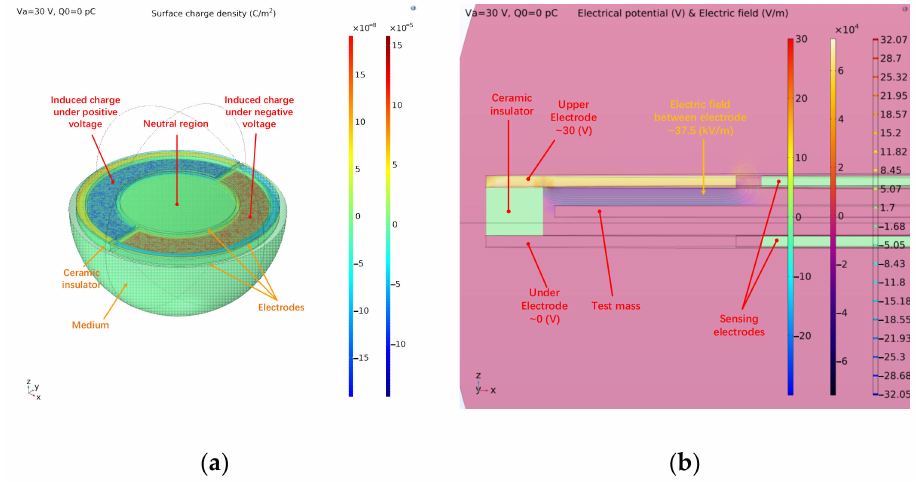
Figure 11. Simulation model for simplified electrode pair: ( a ) Distribution of surface charge density on the mass; the fixed electrodes are set as transparent; ( b ) Distribution of space potential and electric field between